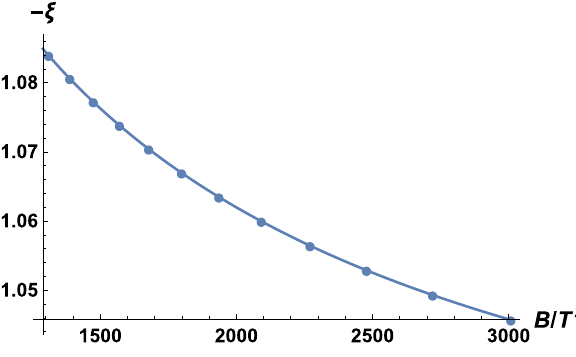
Fig. 2 In the strong B limit, the numerical result of ξ (dots) is fitted by the function (92) when α = λ =